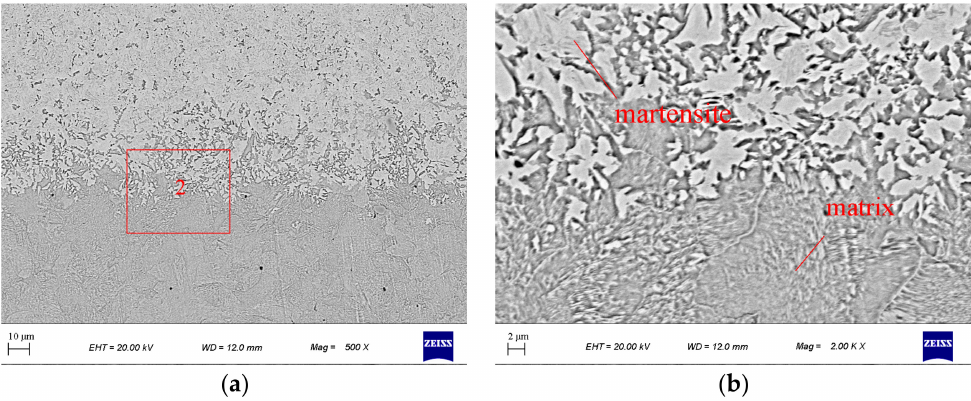
Figure 8. Morphology of the transition zone; ( a ) 500 × magnification and ( b ) area 2 at 2000 × magnification.